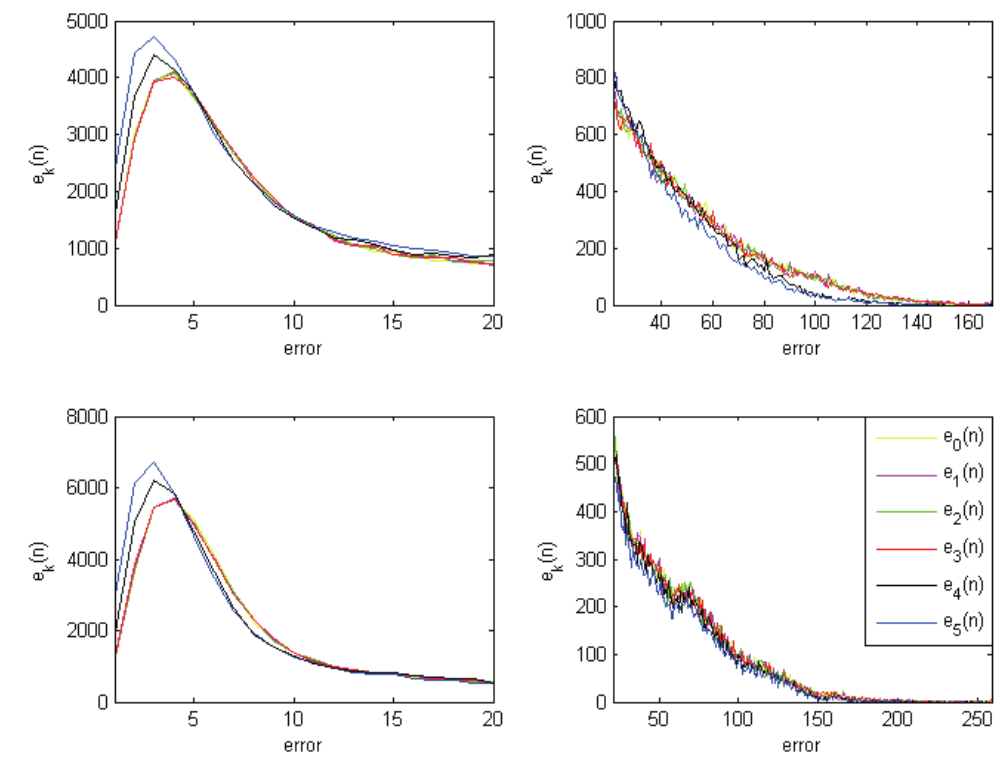
Figure 2. The error image histograms of two